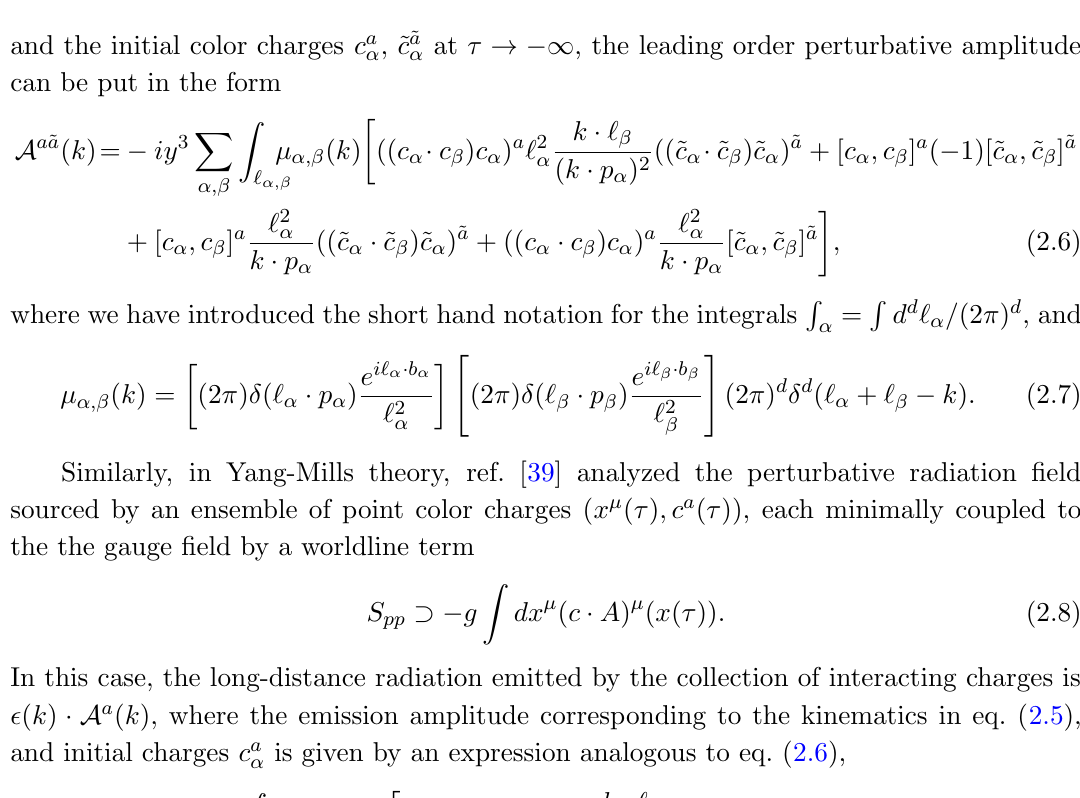
Figure 1 . Calculation of massless bi-adjoint scalar radiation at leading order in perturbation theory. (a) corresponds to the worldline coupling with de(cid:13)ected trajectory via equations of motion, and (b) represents two worldline couplings and a cubic spacetime